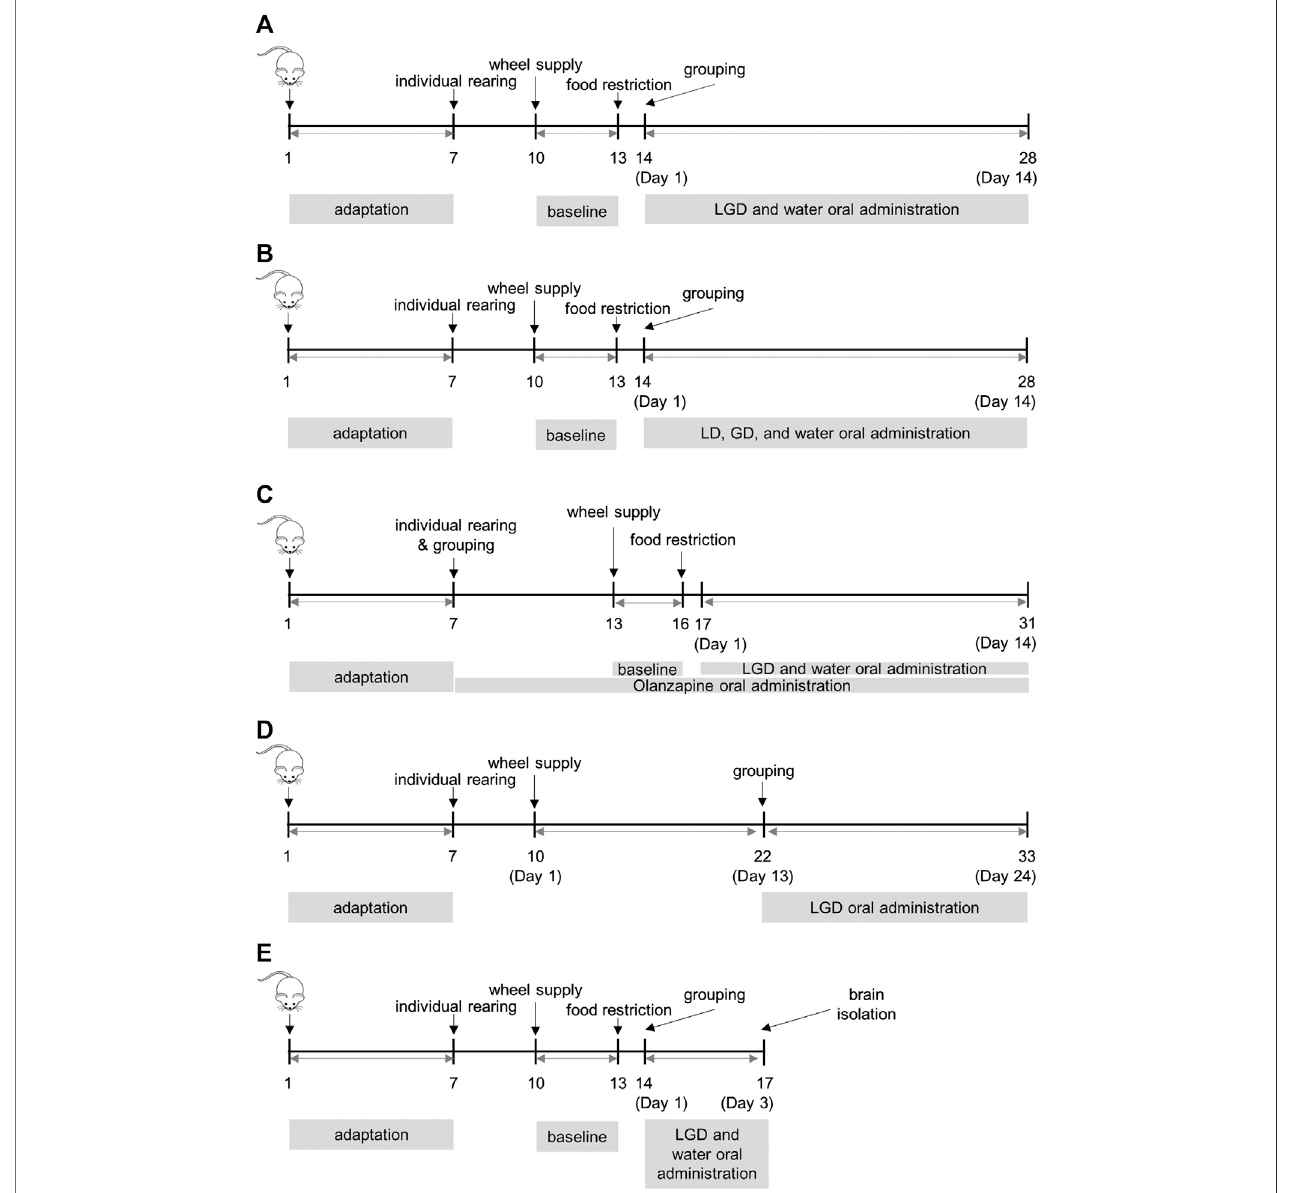
FIGURE1| Proceduresofactivity-basedanorexiaandvoluntaryrunning (A) experiment1:theef fi cacyoflicoriceanddriedgingerdecoction(LGD)inactivity-based anorexia (ABA) mice (B) experiment 2: the ef fi cacy of licorice decoction (LD) and dried ginger decoction (GD) in ABA (C) experiment 3: the comparison of LGD and chronic olanzapine in ABA (D) experiment 4: the effect of LGD in voluntary running mice (E) experiment 5: whole brain dissection for ELISA assay of dopamine, β -endorphin, and dynorphin in ABA.